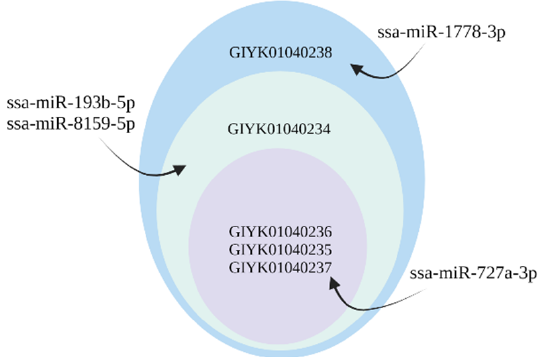
Figure 3. Four gDE miRNAs targeting particular splice variants of cftr1 (five isoforms). Ssa-miR-1778-3p was predicted to target all the splice variants shown in all the circular layers, while ssa-miR-193b-5p and ssa-miR-8159-5p targeted transcripts belonging to the second and inner layers. Ssa-miR-727a-3p targeted only the transcripts in the inner